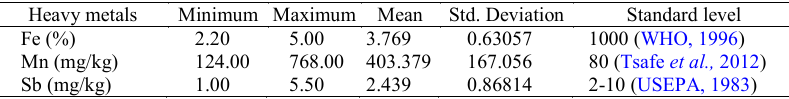
Table 3: Mean concentration of heavy metals in the soils